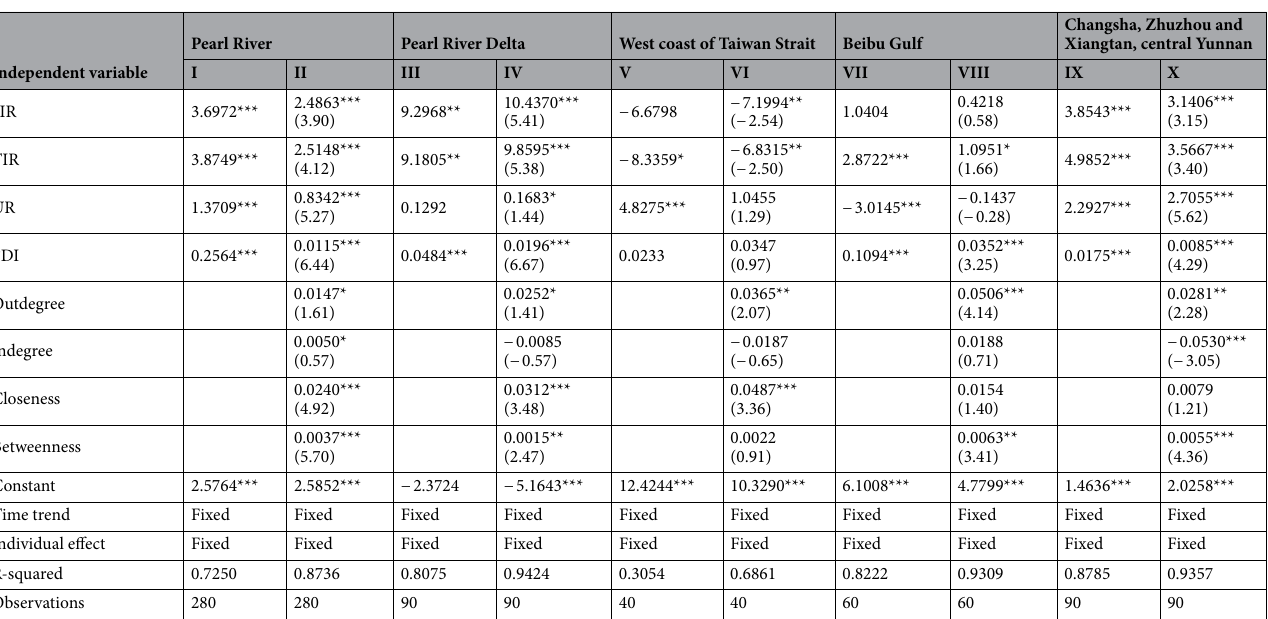
Table 4. The individual effects of network structure in the Pan Pearl River Delta Urban Agglomeration. ***, ** and * indicate the significance levels of 1%, 5% and 10%,